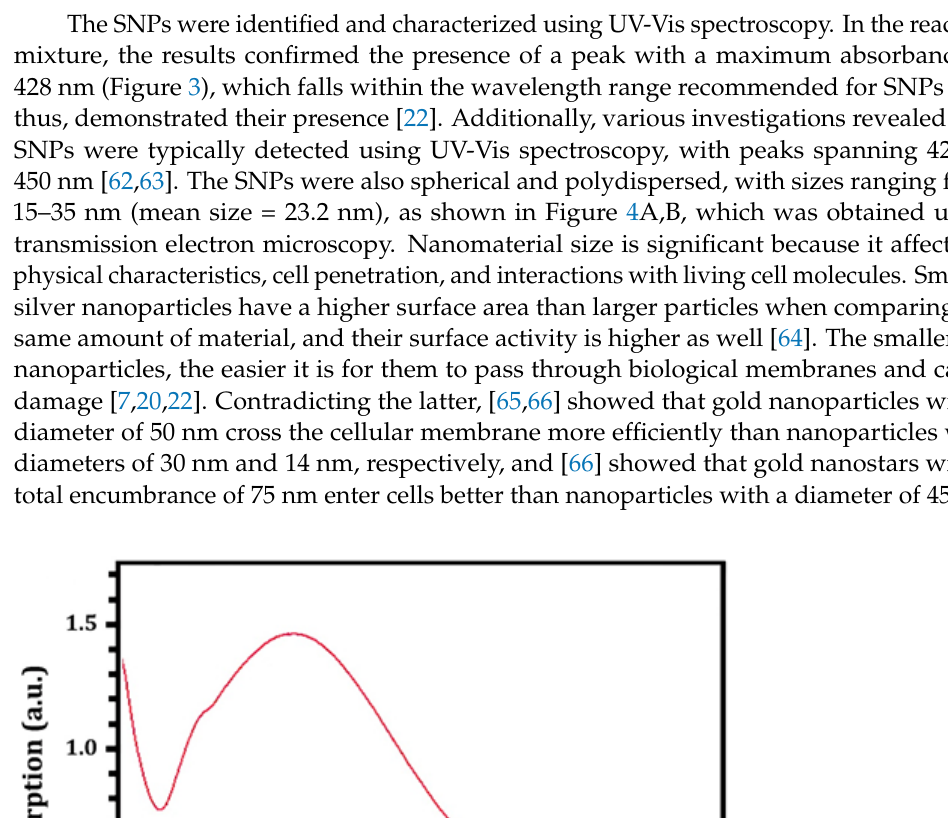
Figure 4. TEM images of the Streptomyces rochei MS 37-derived SNPs. Magnification power at 100 nm ( A ) and at 200 nm ( B ). FTIR analysis was used to identify the biomolecules participating in the reduction of silver ions (Ag+) and the capping of the resulting SNPs. The FTIR spectra of the SNPs had six absorbance bands; 3400, 2925, 1640, 1385, 1013, and 690 cm − 1 (Figure 5). The peak at 3400 cm − 1 is attributed to the stretching vibrations of O-H bonds in alcohols and phenols [67]. The band at 2925 cm − 1 (C–H stretch) belongs to the alkanes group, but the peak at